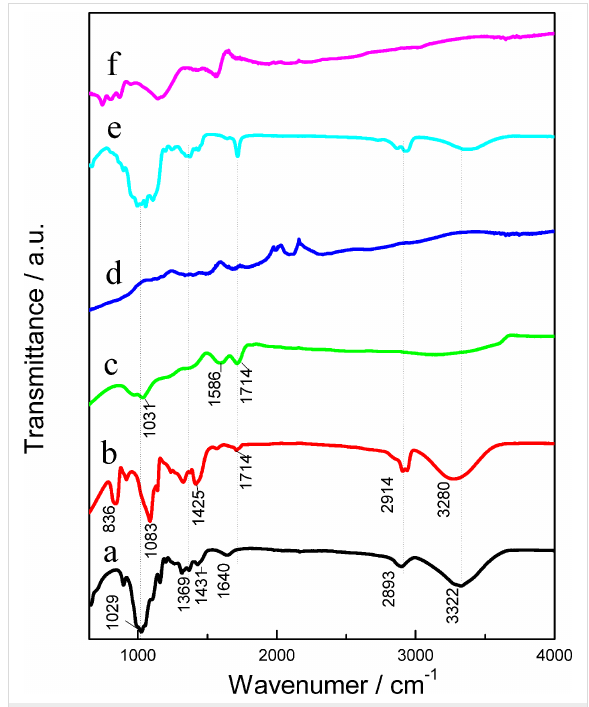
Figure 3: FTIR spectra of the (a) CNFs, (b) PVA, (c) GO, (d) rGO, (e) CNF/PVA/GO aerogel, and (f) CNF/PVA/GO carbon aerogel.